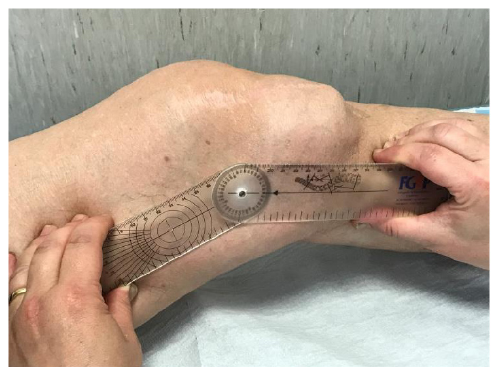
Figure 3. Malformations of the left lower limbs, (hip, knee and ankle), evident at the joint and periarticular level, where diffused exostoses are present.